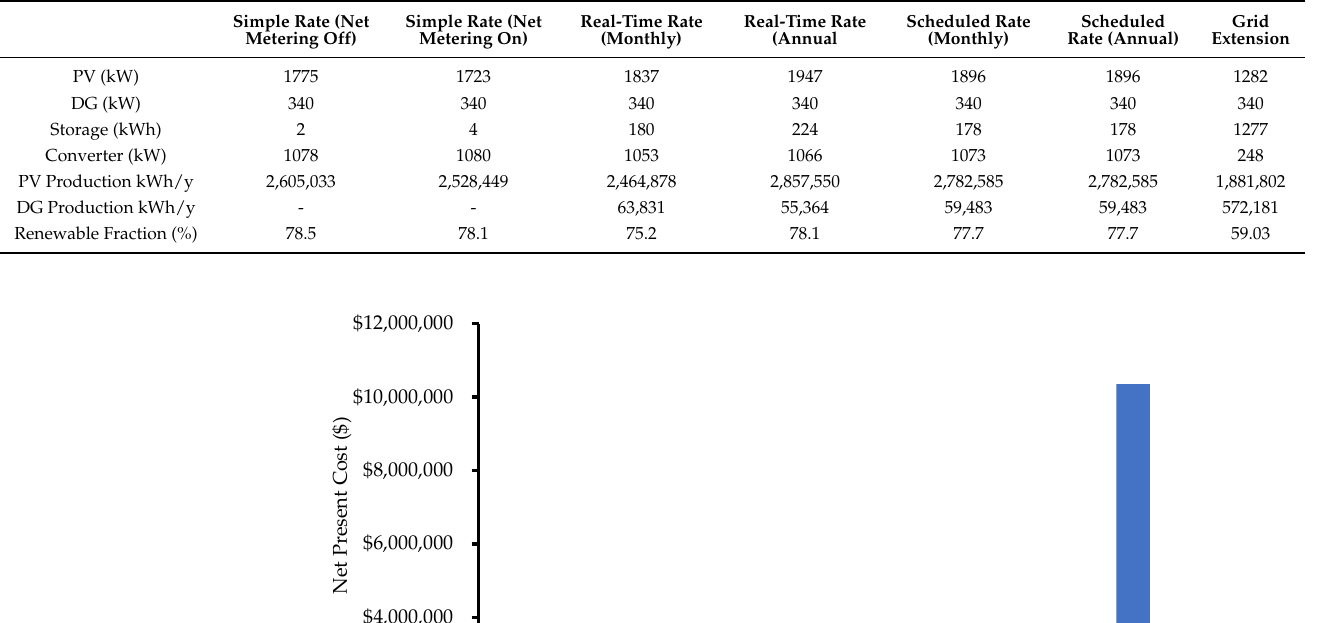
Table 8. Summary of simulation methods.